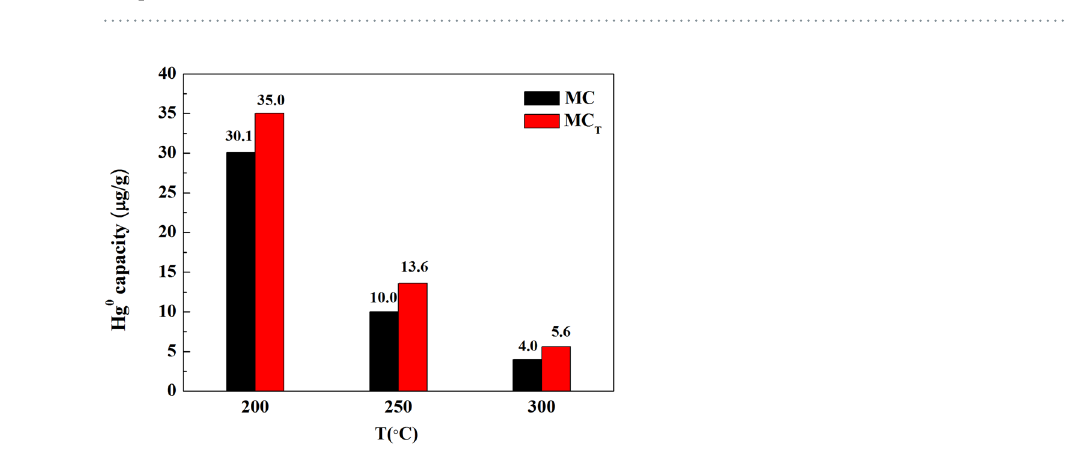
Figure 2. Efficiencies of Hg 0 removal over the Fe 3 O 4 –NH 2 ( a ) and Fe 3 O 4 –NH 2 –Pd ( b ) sorbents at different temperatures.